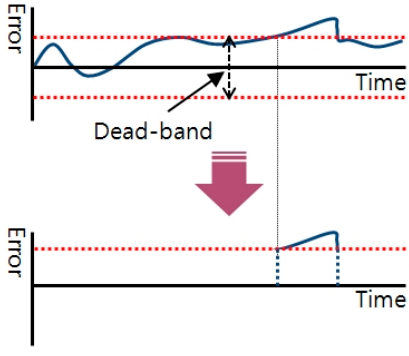
Figure 4. Protection logic rule in the dead-band step.